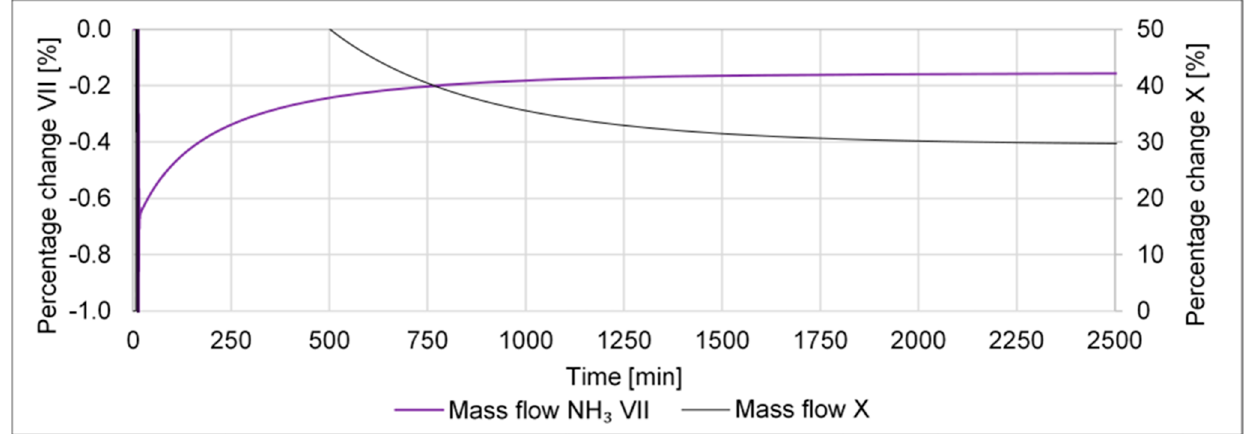
Figure 16 . Percentage change of mass fl ows NH3 VII and X (left and right vertical axis) of scenario Figure 16. Percentage change of mass flows NH3 VII and X (left and right vertical axis) of scenario (f).